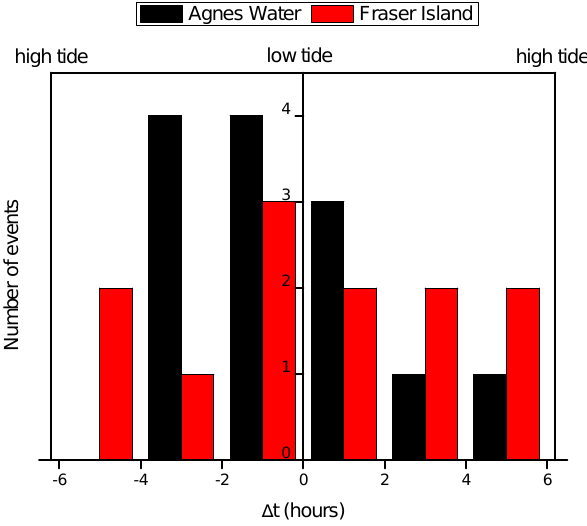
Fig. 8. The number distribution of nucleation events as a function of the time between the beginning of a nucleation event and low tide ( 1 t). Data is grouped into 2h time bins. Distributions are shown for two coastal regions; Agnes Water and Fraser Island (see text for details). The average time between low and high tides during the campaign was 6.2h.